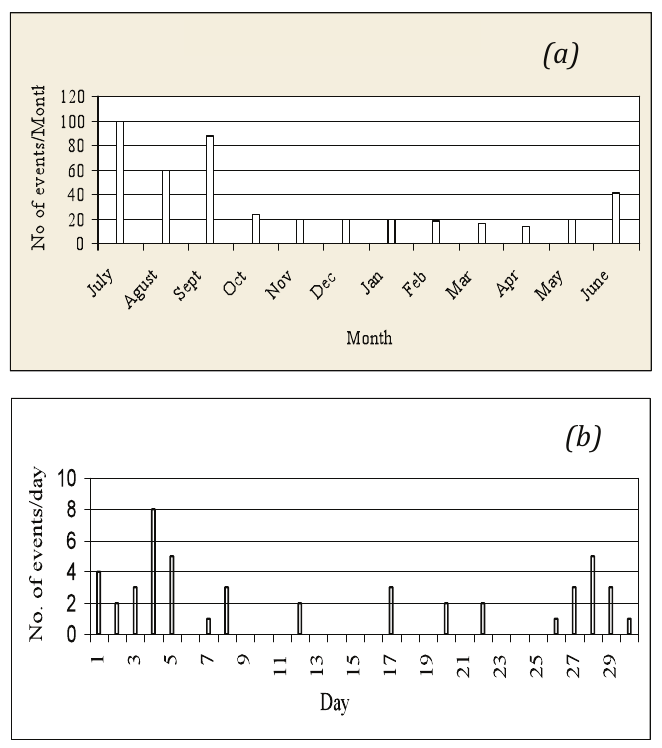
Fig. 5a and b. Seismicity of the Mount Cameroon region showing (a) total seismicity for the year 2000/2001 and (b) daily seismicity for June 2001. Data source: Aka Festus, Institute for Mining and Geological Research,